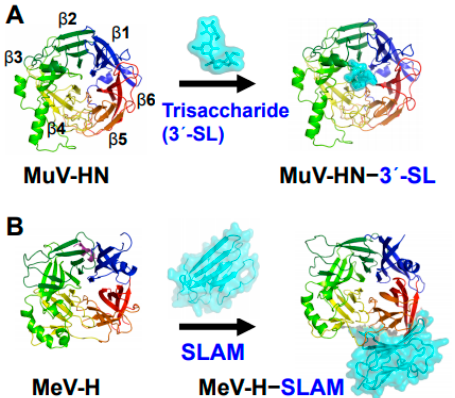
Figure 1. Structures of MuV and MeV attachment proteins bound to their receptors. ( A ) MuV-HN (rainbow color) bound to a glycan receptor analog (cyan) α 2,3-linked sialyllactose (3 ′ -SL) at the top receptor-binding pocket of the head domain; ( B ) MeV-H (rainbow color) bound to a proteinaceous receptor SLAM (cyan) at the lateral side of the head domain. The head domains of both MuV-HN and MeV-H monomers exhibit a six-bladed β -propeller fold.